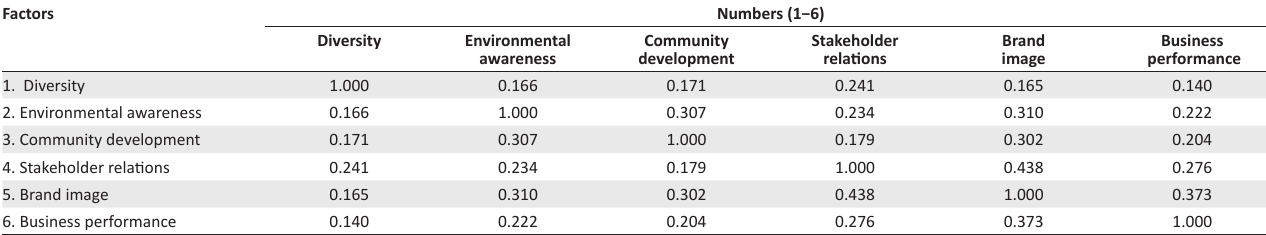
TABLE 5: Pearson’s correlations coefficients. Factors